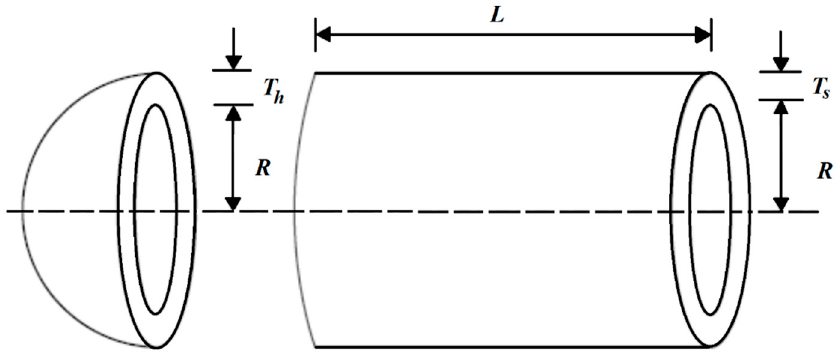
Figure 8. Schematic of the pressure vessel design.